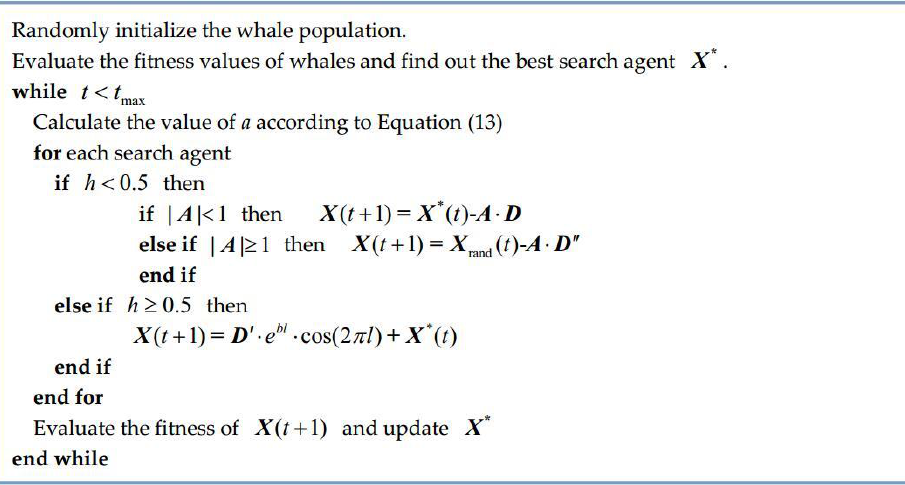
Figure 1. The pseudo code of the original whale optimization algorithm (WOA).